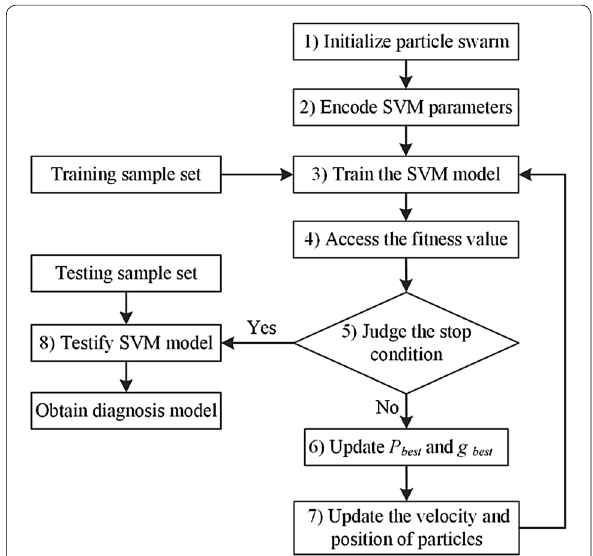
Figure 7 Flow chart of the PSO-SVM fault diagnosis model